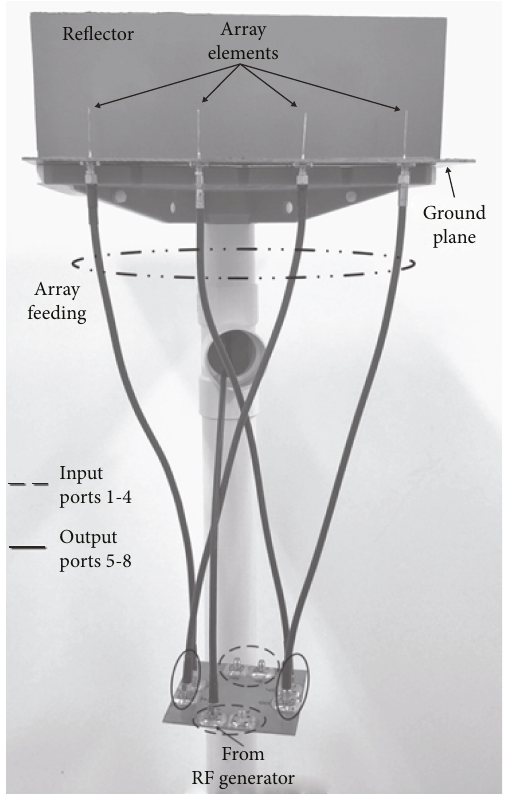
Figure 11: Picture of the 4 × 4 BM connected to the 4-monopole antenna.